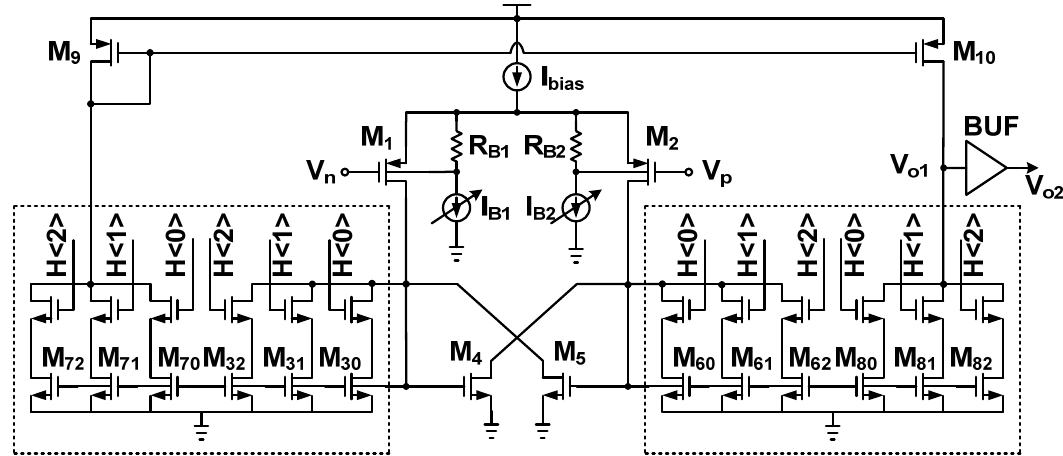
Figure 7. Proposed programmable hysteresis comparator with body-biasing-based DC offset cancellation.